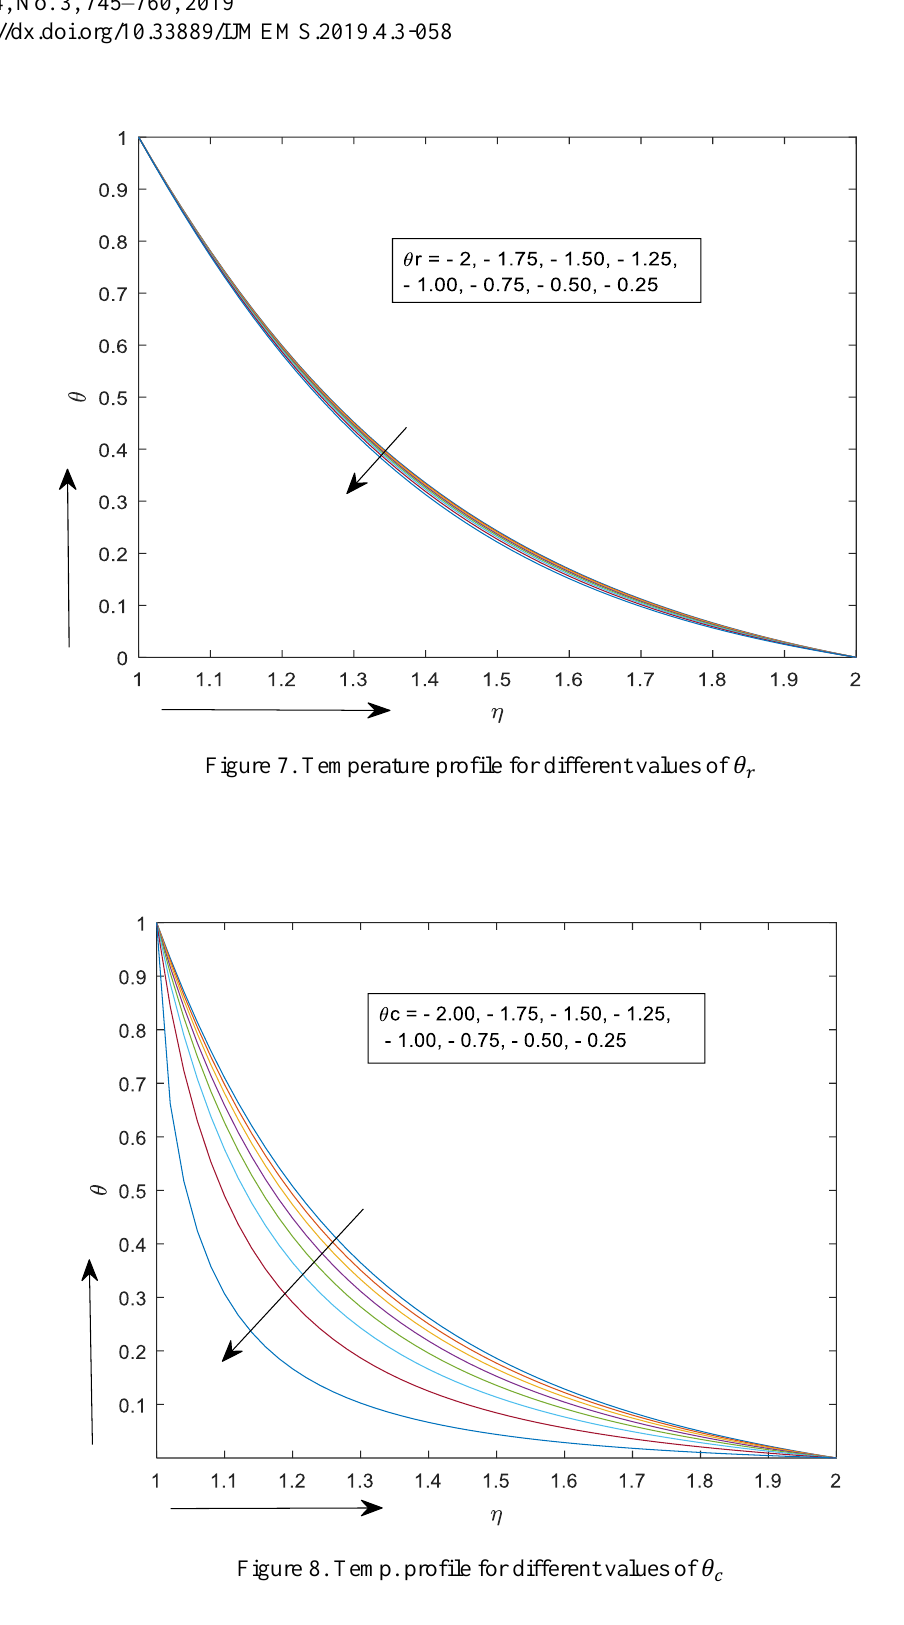
Figure 8. Temp. profile for different values of 𝜃